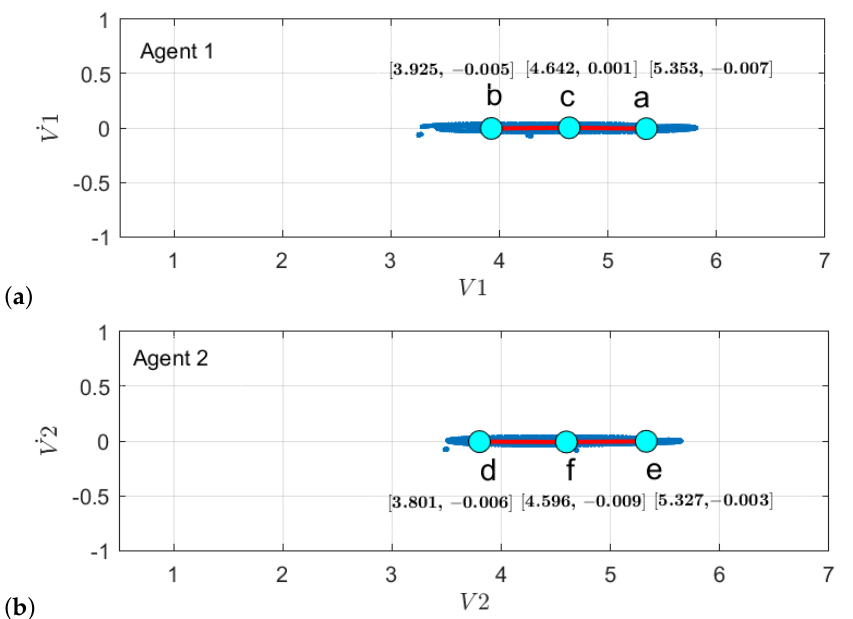
Figure 11. Clustering of GEs produced by applying unmotivated Kalman filter on the training data for ( a ) agent 1 and ( b ) agent 2